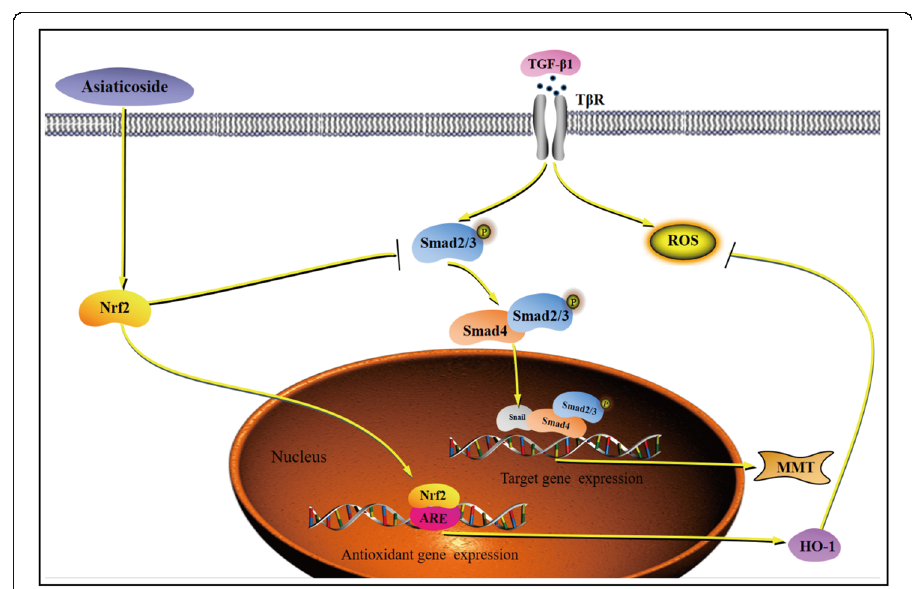
Fig. 8 Schematic diagram illustrating the mechanism by which asiaticoside inhibited MMT and ROS